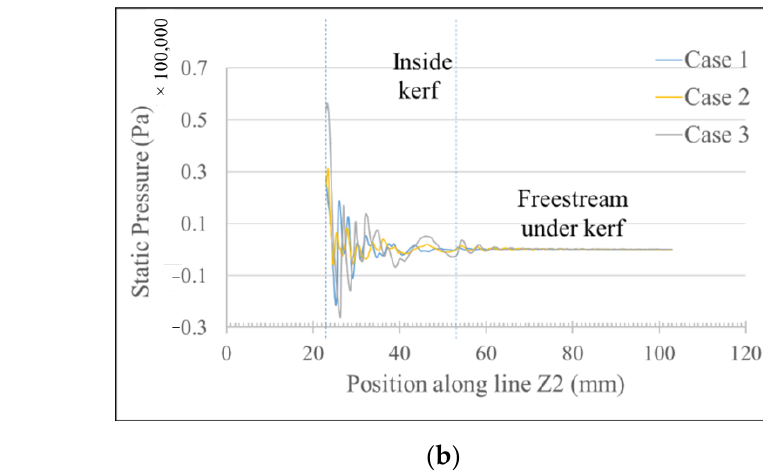
Figure 12. Pressure distribution curve for various nozzle configurations in kerf slot (l offset = 3 mm): ( a ) along line Z1 and ( b ) along line Z2.